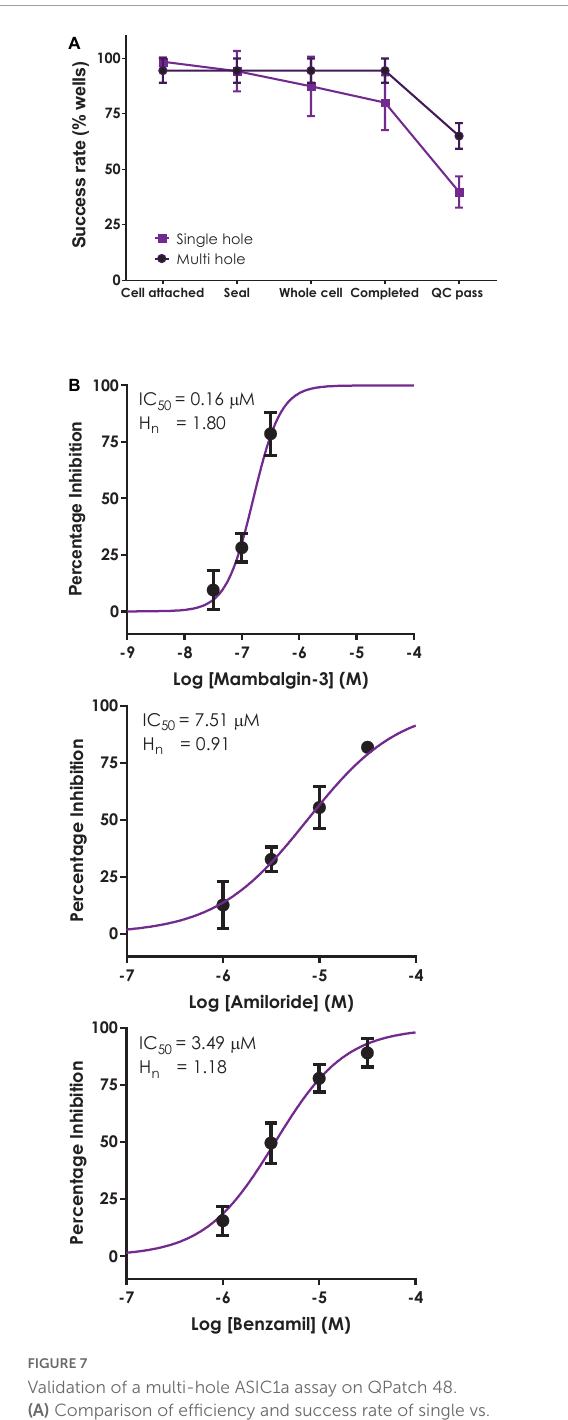
FIGURE7 Validation of a multi-hole ASIC1a assay on QPatch 48. (A) Comparison of efficiency and success rate of single vs. multi-hole QPlate assay format. Mean ( ± S.D) data for the percentage of wells that passed various quality control (QC) criteria during and after whole-cell recordings in single hole ( n = 4 plates, black squares) or multi-hole mode ( n = 5 plates, filled circles). (B) ASIC1a assay pharmacology in multi-hole mode. Mean ( ± S.D) concentration-response data for inhibition of ASIC1a currents by Mambalgin-3 ( n = 12), Amiloride ( n = 8) and Benzamil ( n = 4) in multi-hole recordings, with indicated IC 50 and Hill slope